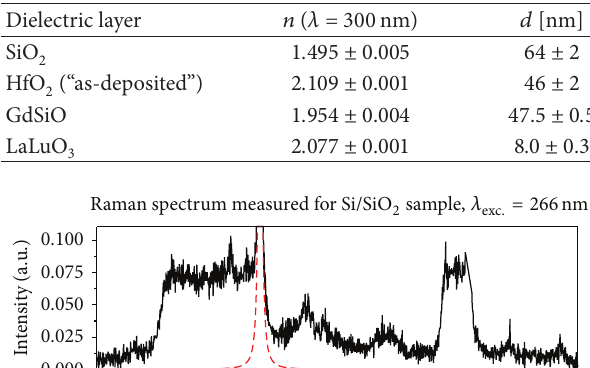
Table 1: Refractive indices obtained for excitation wavelength equal to 300 nm and film thicknesses measured by means of spectroscopic ellipsometry for silicon dioxide, hafnium oxide, gadolinium-silicon oxide, and lanthanum-lutetium oxide.